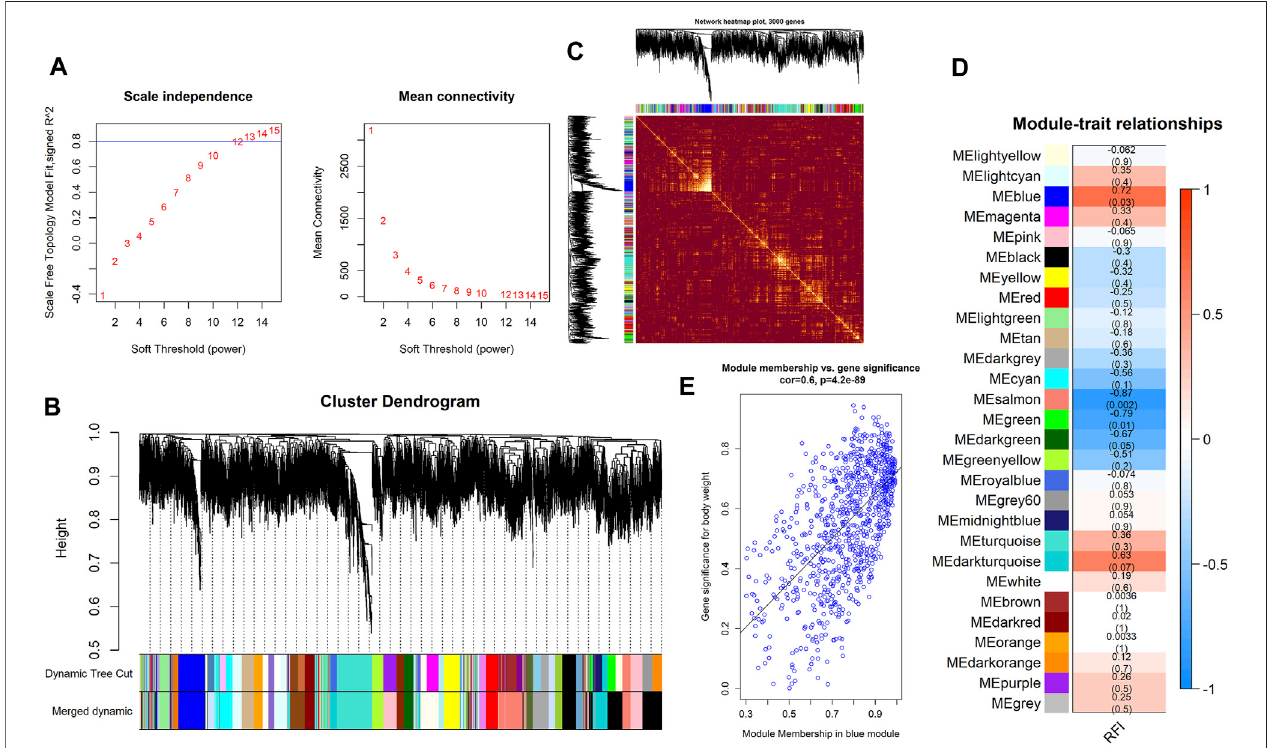
FIGURE 5 | Key fi ndings from the module – trait correlations analyses. (A) The analysis of the scale-free fi t index (left) and mean connectivity for diverse soft- thresholding powers (right) . (B) Clustering dendrogram of DEGs associated with RFI. (C) Network heatmap in the co-expression modules (the yellow color scale indicates the degree of overlap between functional modules). (D) Heat map of the correlations between modules and RFI (each cell contains the correlation coef fi cient and its p -value). (E) Signi fi cance of genes contributes to RFI in the blue module (one dot denotes a gene in the blue